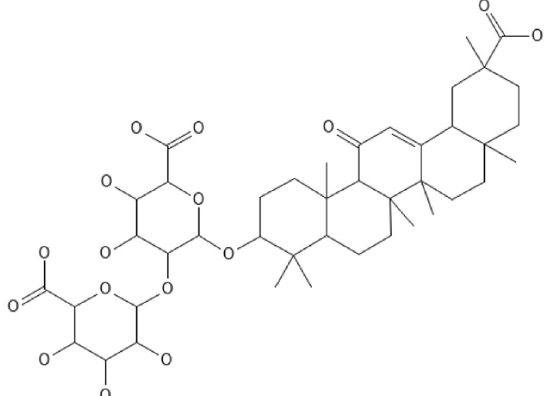
Fig. 1 Structure of glycyrrhizin, a triterpenoid class of saponin found in